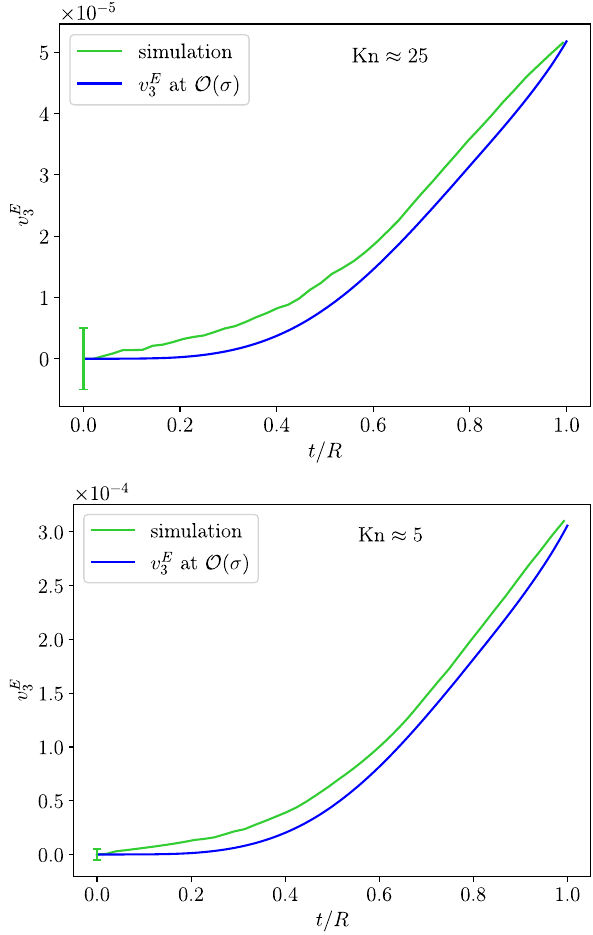
Fig. 12 Early time evolution of ε p the 2 → 0 simulation are shown in green, the analytical calculation at O (σ) in blue